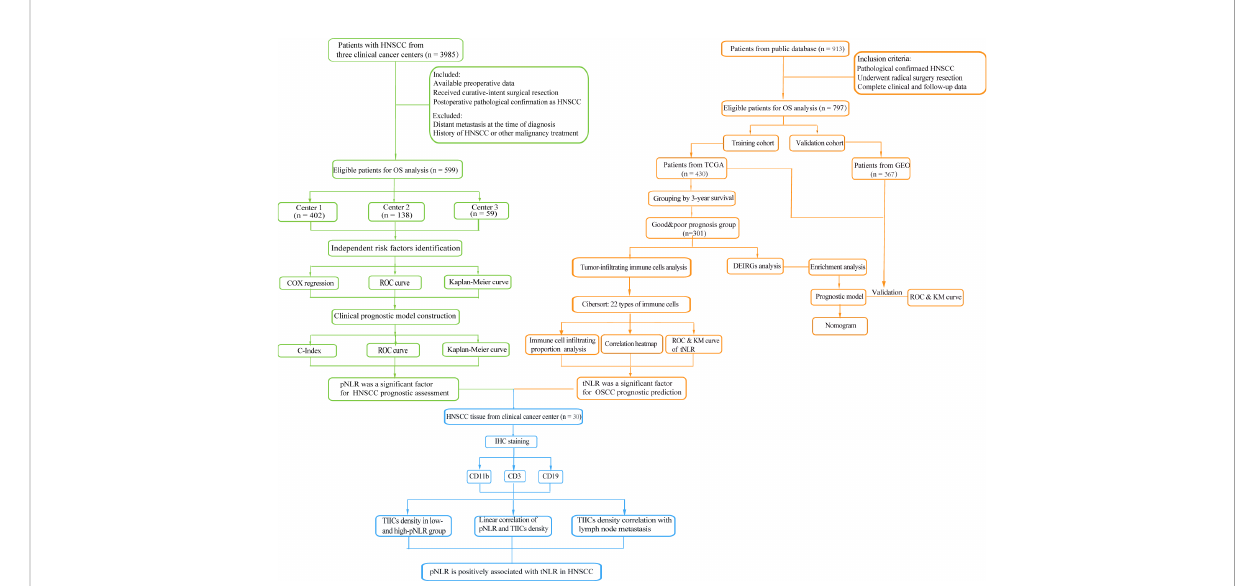
FIGURE 1 Flowchart of this study. A total of 599 patients from three clinical centers and 913 patients from a public database were collected to respectively identify the prognostic peripheral immune signature (pIS) and prognosis-associated tumor immune microenvironment (TIME) feature. The correlation between the pIS and the TIME was con fi rmed in a 30 head and neck squamous cell carcinoma (HNSCC) patients ’ cohort.